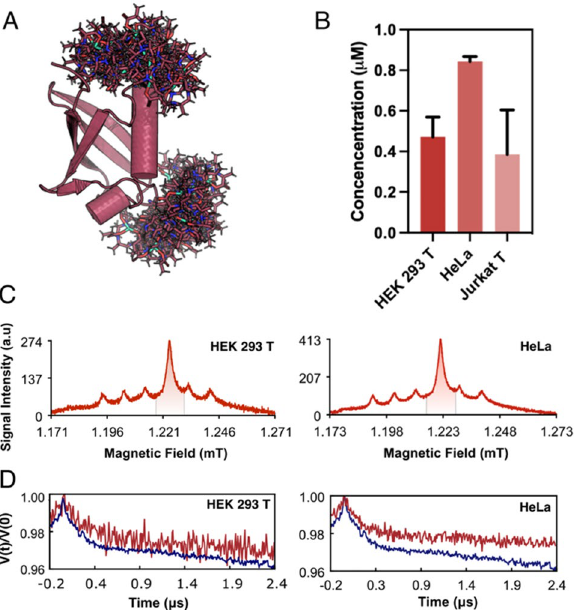
Figure 5. ( A ) Model structure of human ubiquitin protein labelled with doubly Maleimide DOTA Gadolinium tag in the S20C and G35C position. ( B ) Derived bulk intracellular concentration for the Ub-ma-DOTA-Gd 3+ delivered cells. The concentration was estimated interpolating the Integral value of the in-cell spectra Gd 3+ transition with a calibration curve. ( C ) Acquired EDFS spectra for the HEK 293 T and HeLa cells over the center of the resonator dip under overcoupling conditions. ( D ) DEER spectra acquired for the in vitro (blue traces) and the relative in-cell sample (red